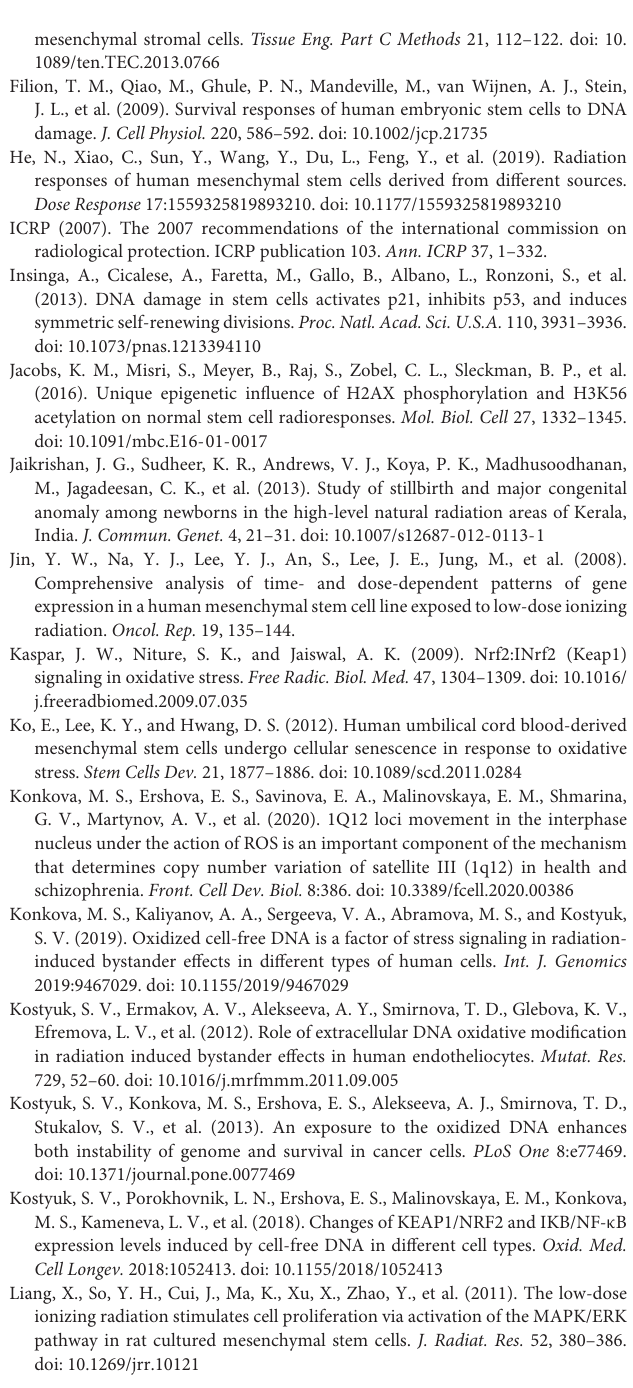
Supplementary Figure 1 | (A) Autofluorescence of the irradiated MSCs (10 cGy) #2278. Photographs were taken with various fluorescent